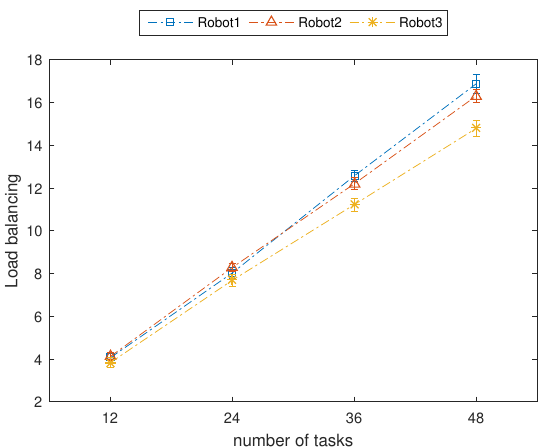
Figure 10. Average number of tasks executed per robot using DYMO-Auction.